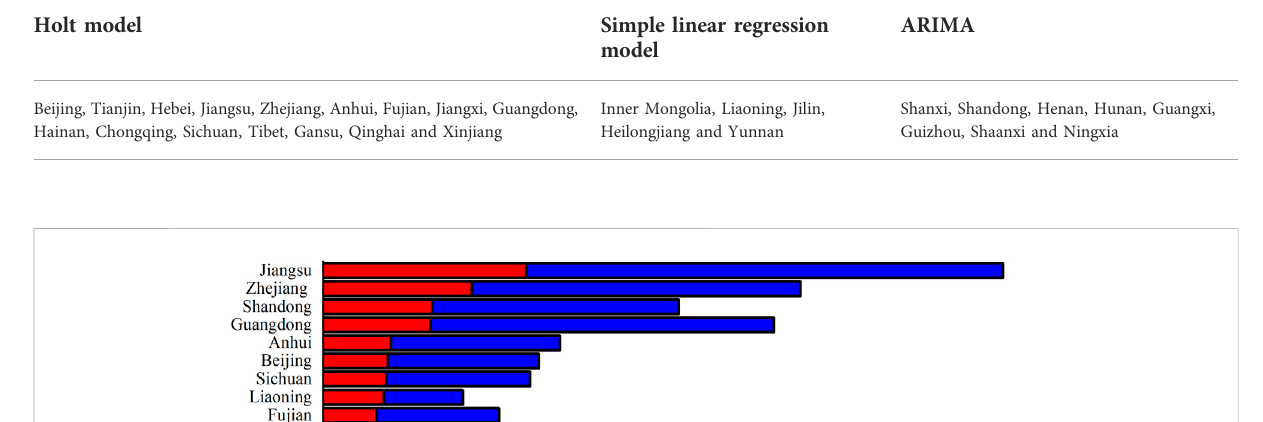
TABLE 3 Classi fi cation table of forecasting models used by 31PLAD.